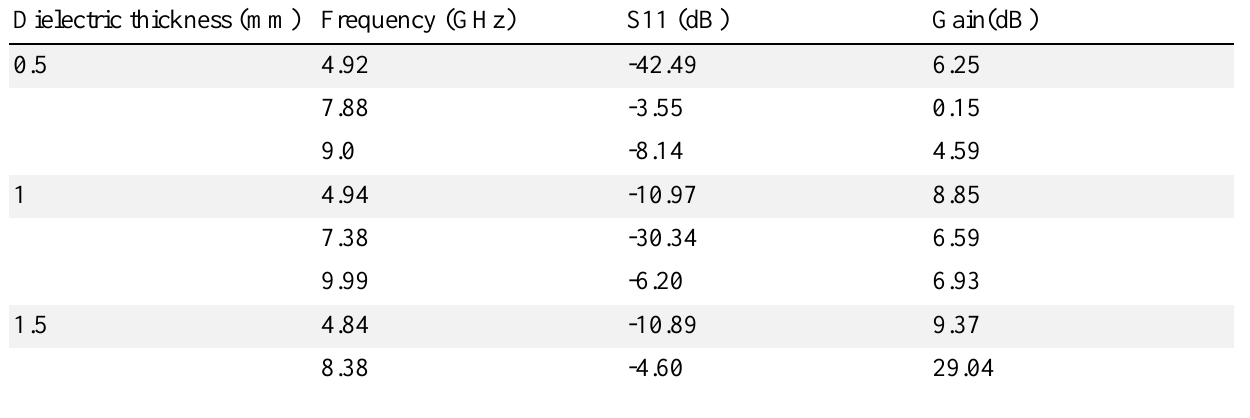
Table 4. Changing dielectric thickness